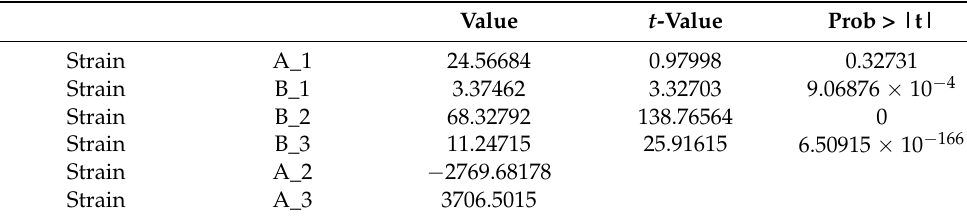
Table 3. Test parameters for significance of fitting curve (blue curve) of Figure 11b.